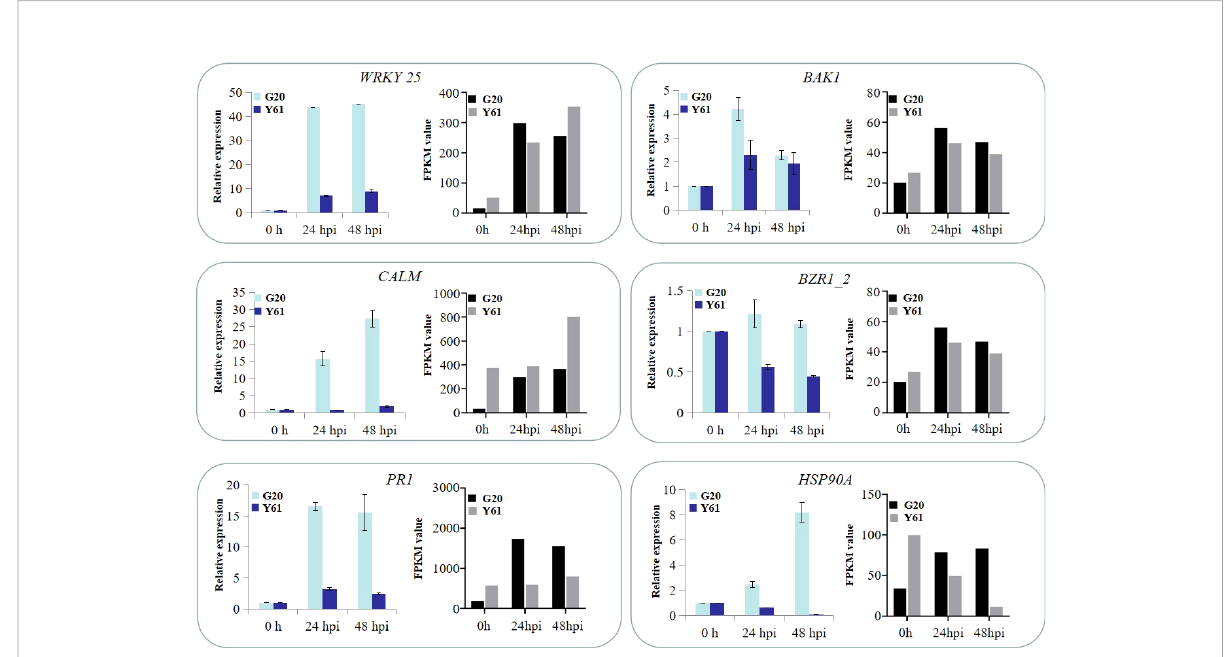
FIGURE 9 Expression pro fi le comparisons between RNA-Seq and qRT-PCR data. The relative expression levels of six DEGs after C. brevisporum infection, including WRKY transcription factor 25 (WRKY 25), brassinosteroid insensitive 1-associated receptor kinase 1 (BAK1), CALM, brassinazole resistant 1-like (BZR1_2), pathogenesis-related protein 1-like (PR1), and heat shock protein 90